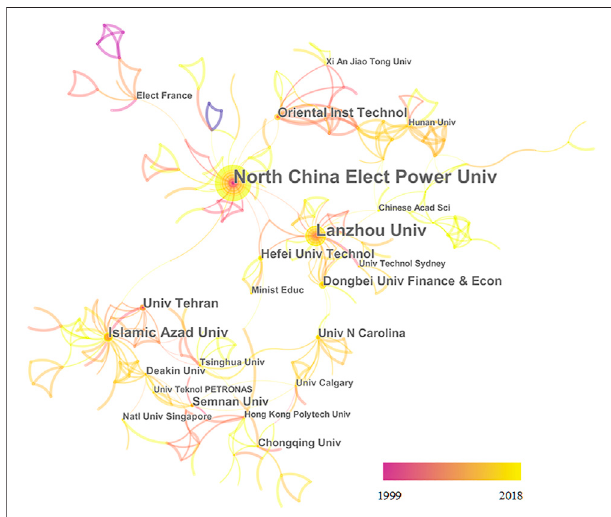
FIGURE 7 | Institutional cooperation network in electricity demand forecasting.